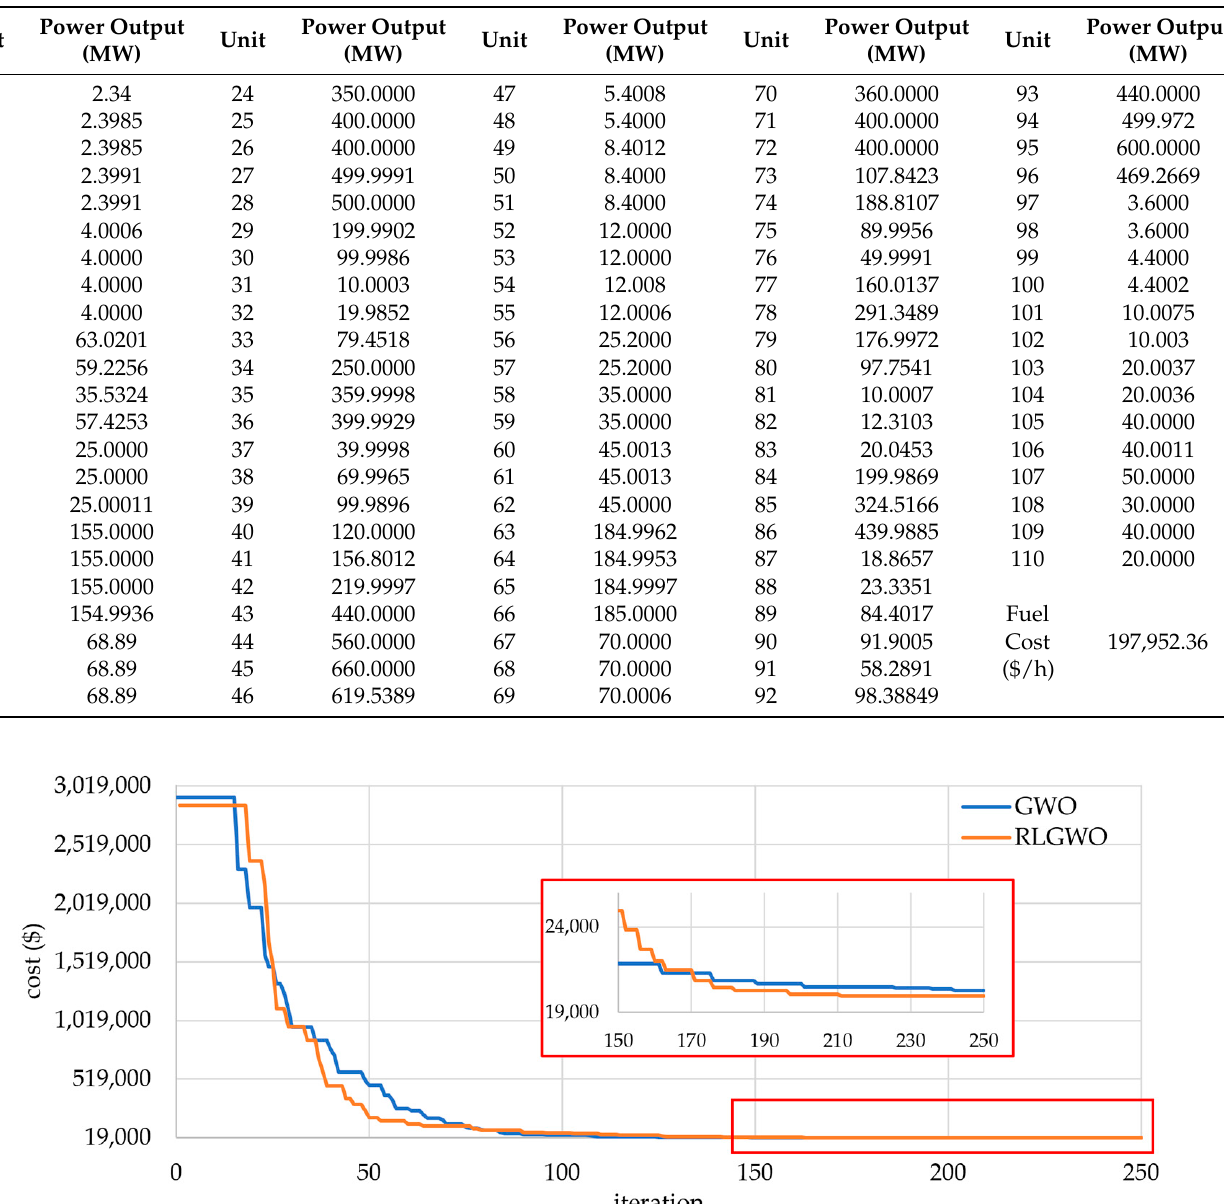
Table 5. Best simulation results for the 110-unit system with loss ( P D = 15,000 MW).